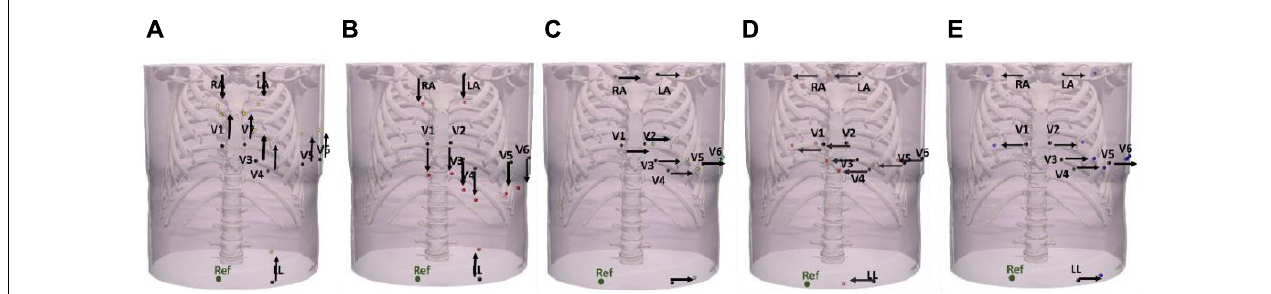
FIGURE 7 | Variations in ECG electrode placements. ECG leads were displaced by ∼ 5 cm upward (A) , downward (B) , toward the left (C) , toward the right (D) , and by ∼ 10 cm (mixed displacements toward the right and left) (E) .